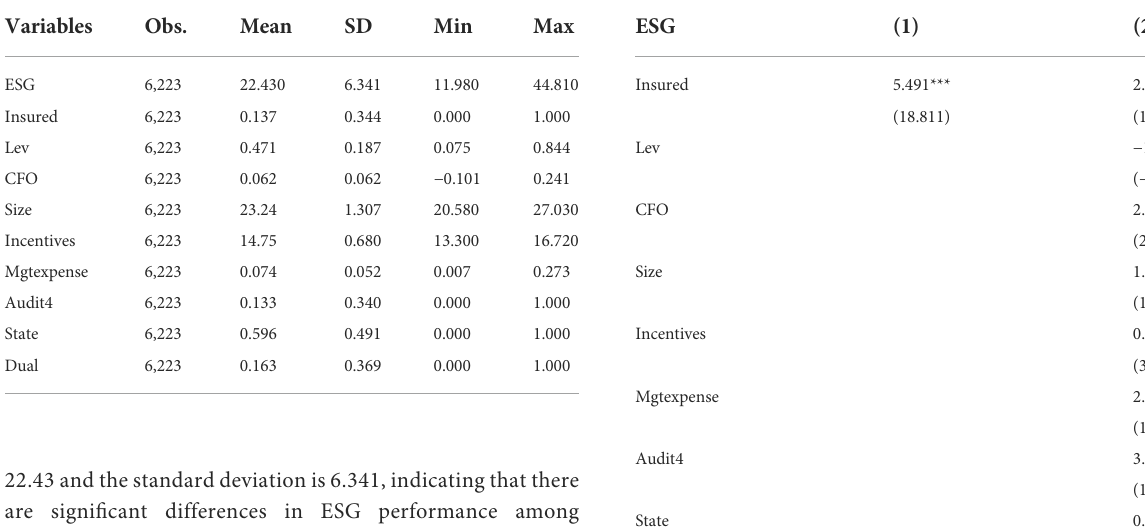
TABLE 1 Descriptive statistics. TABLE 2 The impact of D&O insurance on ESG